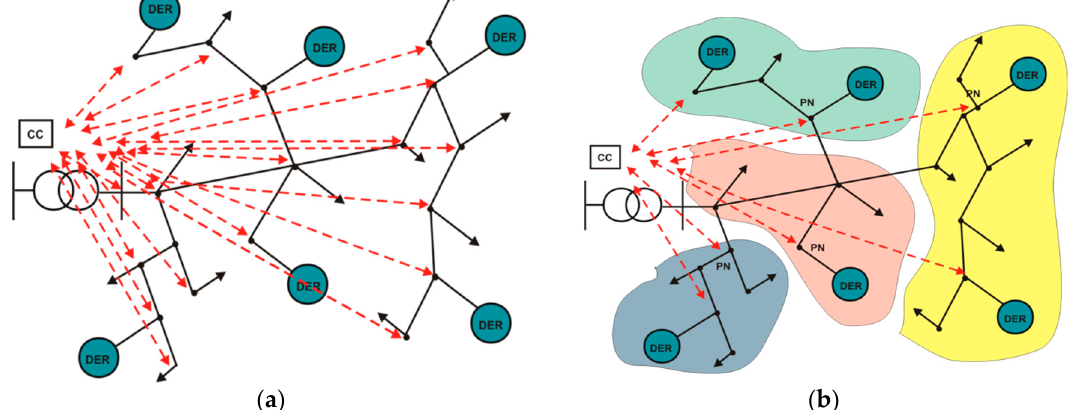
Figure 1. Simplified representation of the communication system of a centralized control; ( a ) fully centralized; ( b ) centralized by voltage control zones (VCZs).